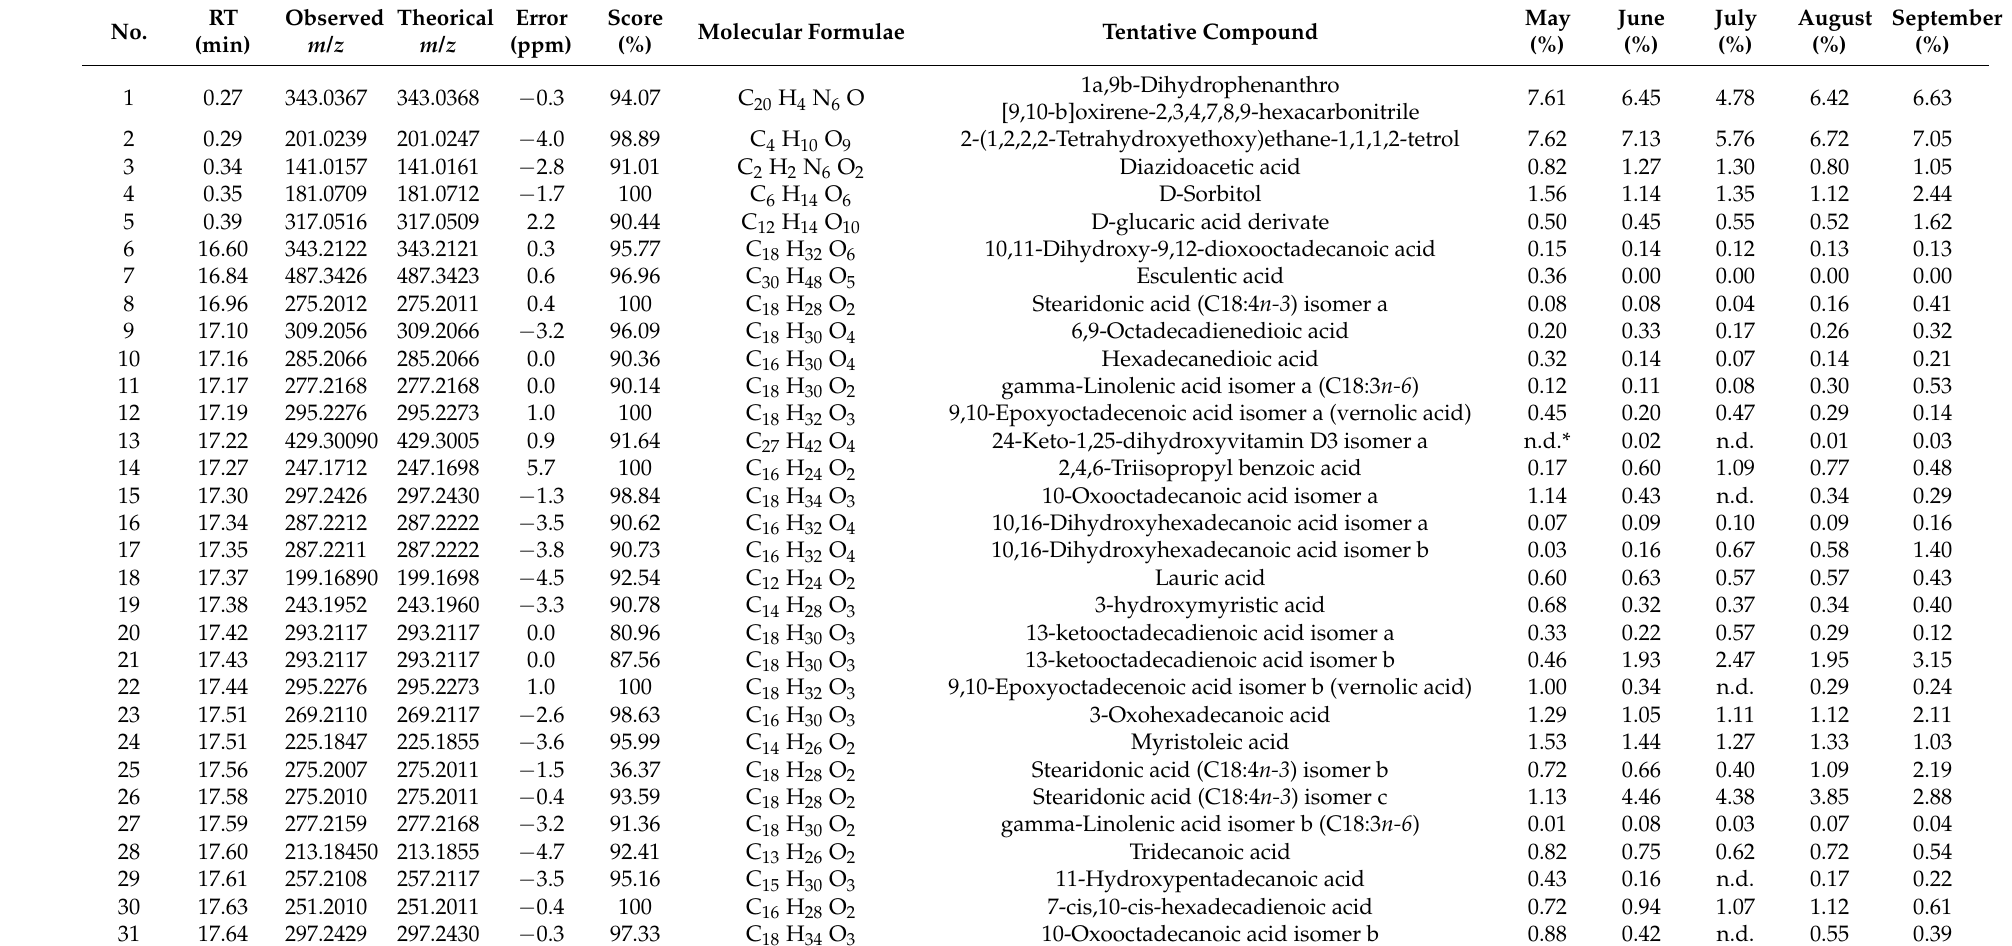
Table 3. The list of compounds detected in P. pavonica extracts analyzed by